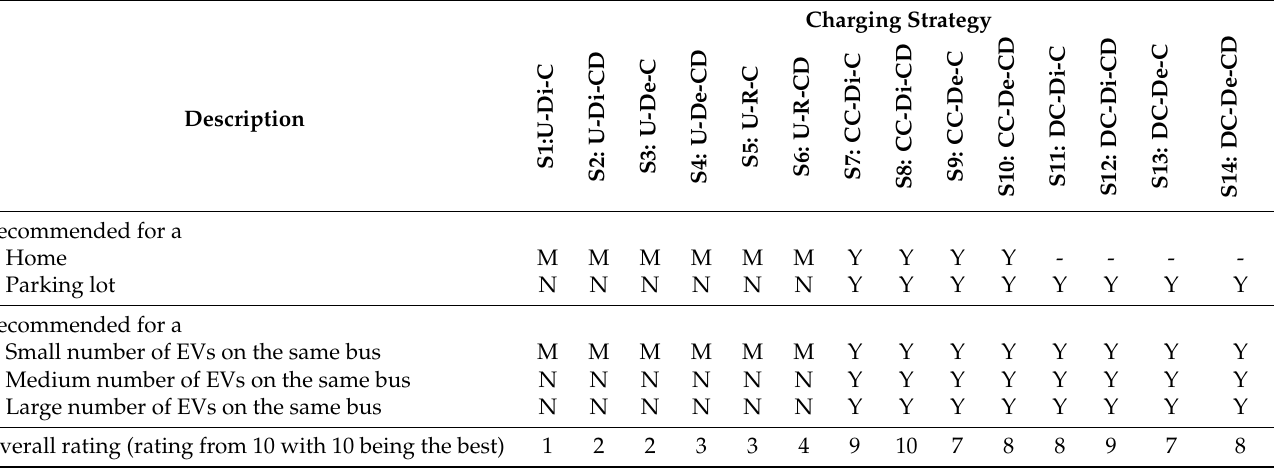
Table 11. Final Recommendations from Our